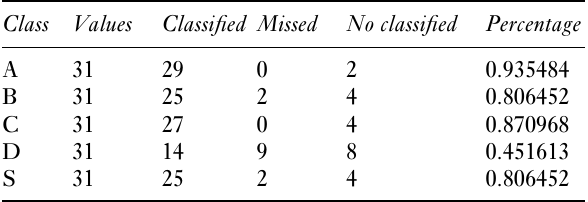
Figure 11 The complex action for the open door task. The initial state is the pre-conditions of the Search(Handle), and the final state is the post-conditions of Leave(Handle). Table 2 The performance of the classification method for 5 different letters. The average performance of the system is